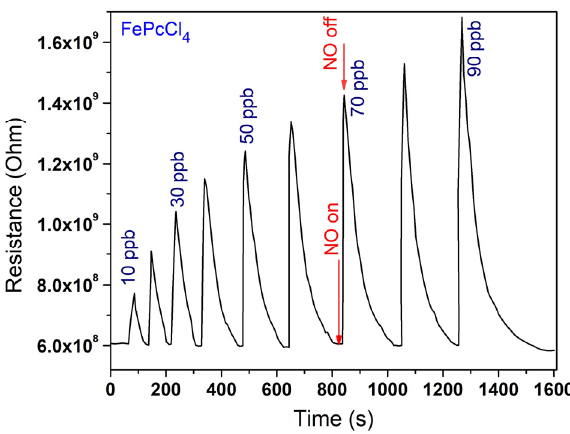
Figure 7. Typical sensor response of a FePcCl 4 film to NO (10–90 ppb).